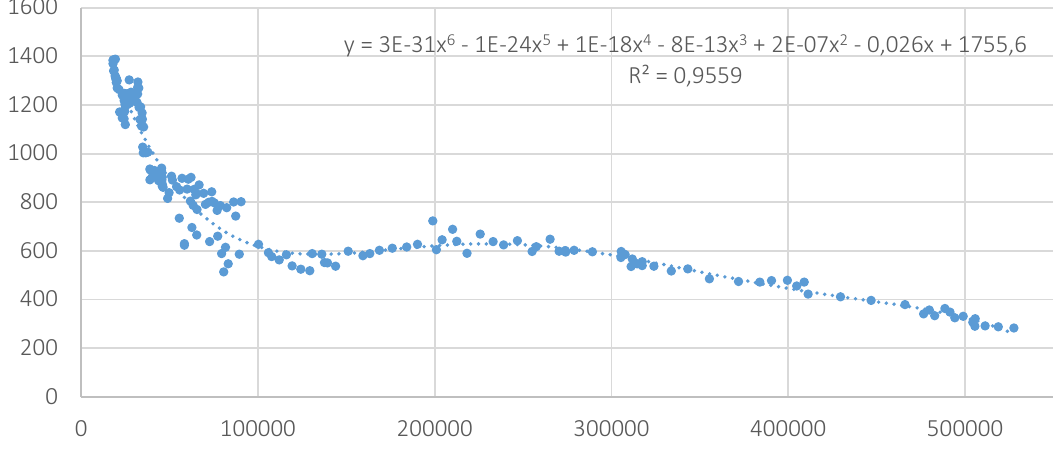
y = 3E-31x 6 - 1E-24x 5 + 1E-18x 4 - 8E-13x 3 + 2E-07x 2 - 0,026x + 1755,6